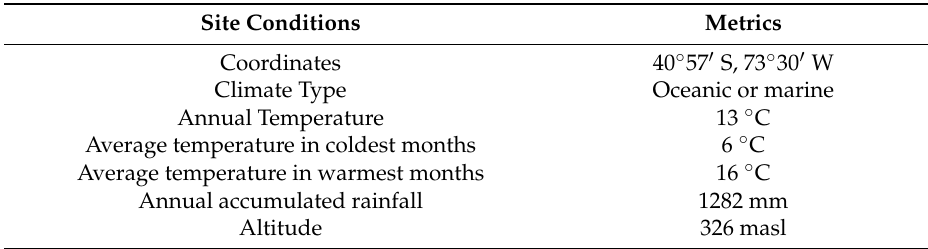
Table 1. Site conditions of La Poza, municipality of Purranque, Chilean administrative region of Los